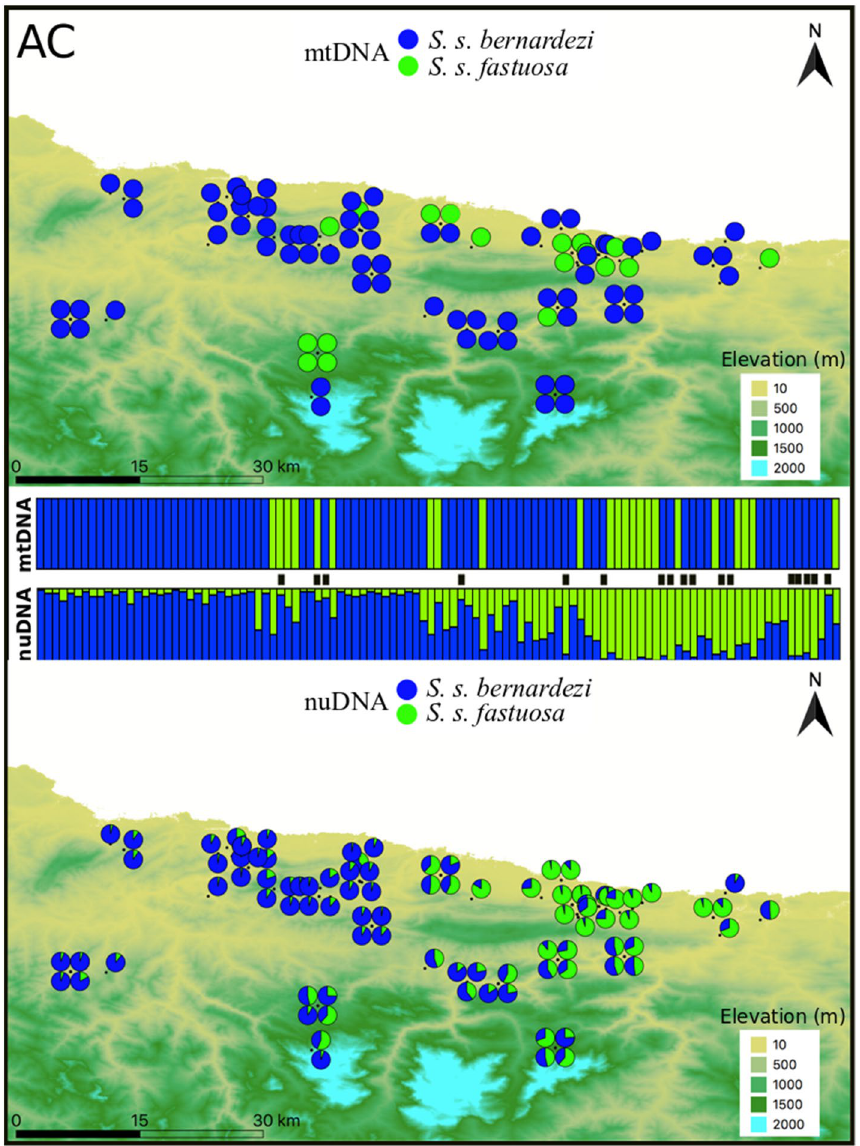
Figure 4. Genetic structure of S. salamandra across the Asturian-Cantabrian border (AC) as inferred by both mitochondrial (upper panel; two main lineages separating S. s. bernardezi and S. s. fastuosa ) and nuclear DNA (lower panel; STRU CTU RE K = 2). Samples in the barplots are arranged from west to east. Genetic assignment to S. s. bernardezi and S. s. fastuosa is colour-coded in blue and green, respectively. Black bars between structure plots indicate individuals with mitonuclear discordance (16%). The figure was created with QGIS software (version 3.2; https:// qgis. org/ en/